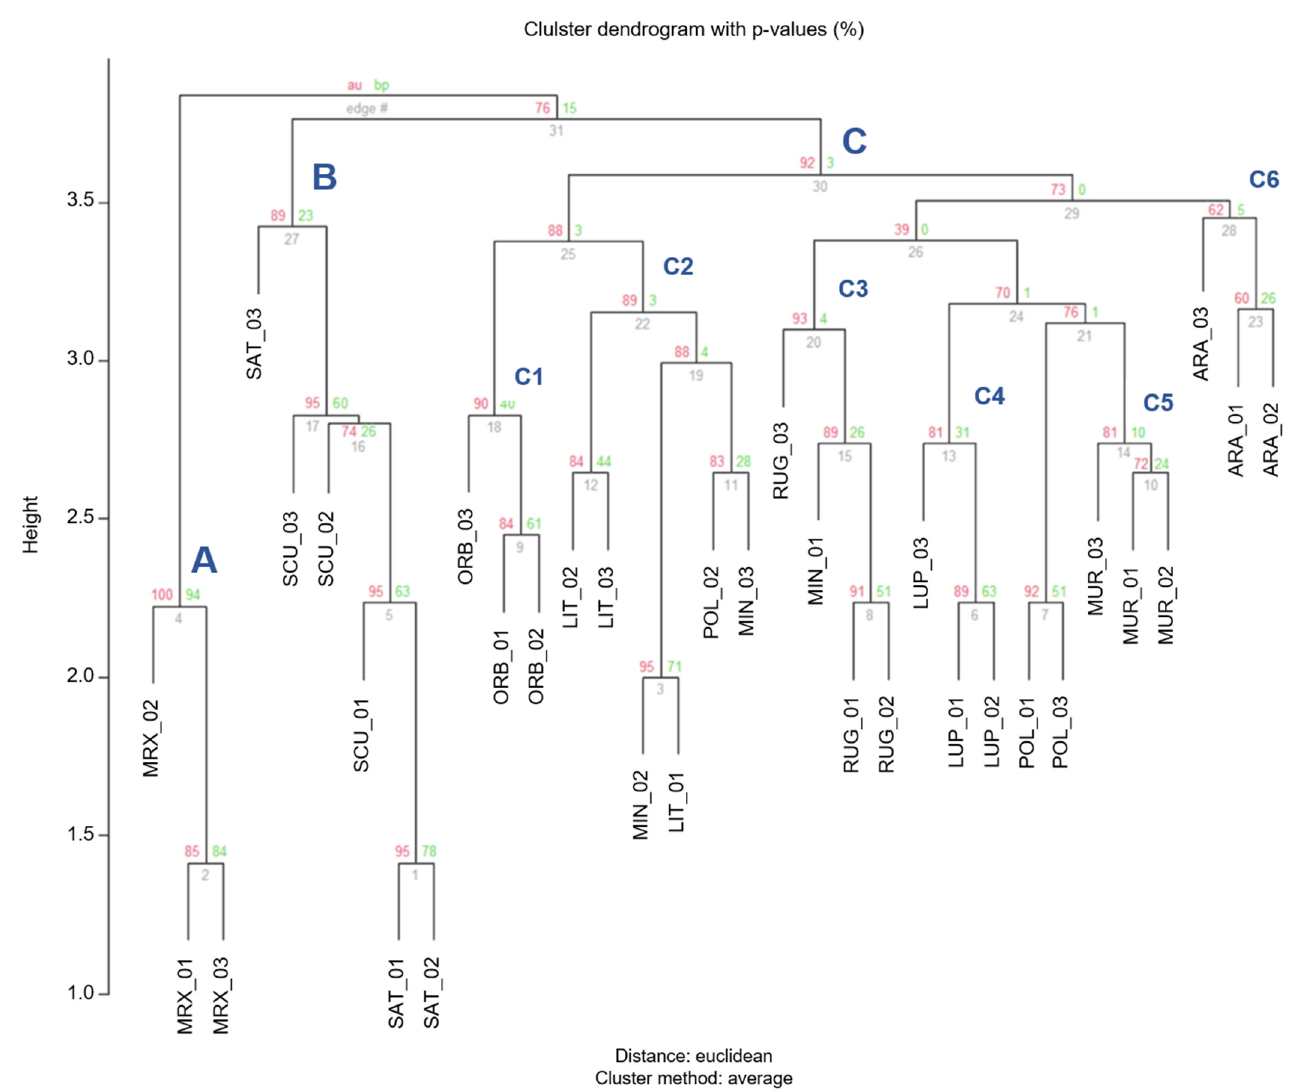
Figure 7. Cluster dendrogram of individuals based on the Euclidean distances. Values at branches are AU p -values (red) and bootstraps BP-values (green), based on cp-SSR and n-SSR markers.